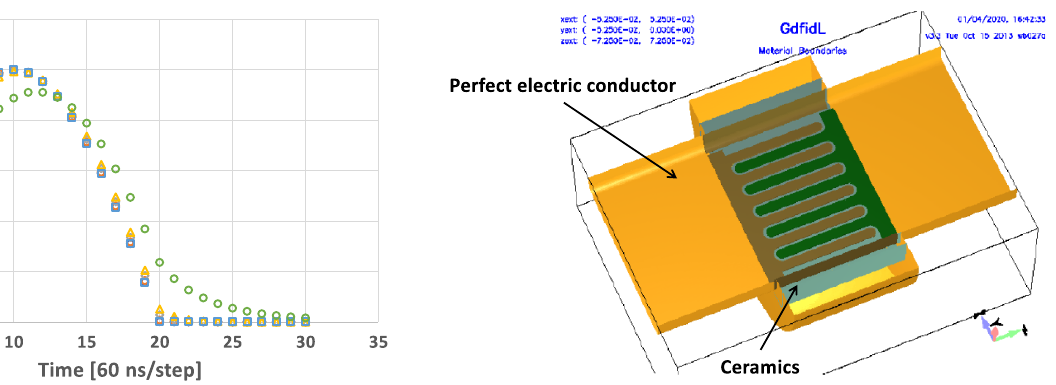
FIG. 13. The eddy-current magnetic field is suppressed at an off-center position of the magnet, through which the injection beam passes.